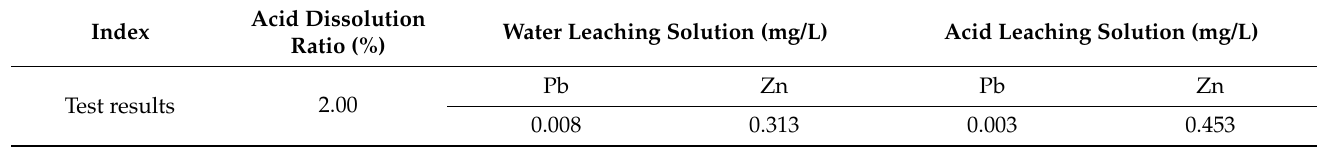
Figure 15. ( a ) The phase diagram of CaO-SiO 2 -Al 2 O 3 ; ( b ) X-ray diffraction results of slag from additive test. Table 7. The leaching test results of slag from the auxiliary agent